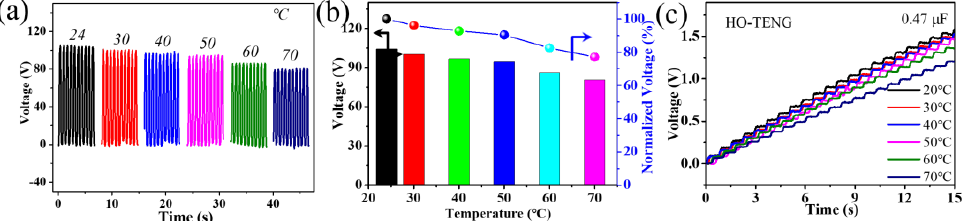
Figure 8. Electrical output of flexible HO-TENG at different operating temperature. ( a ) V oc , ( b ) normalized voltage, ( c ) charging performance of flexible HO-TENG to a commercial capacitor of 0.47 µ F. Table 1. Normalized voltage/current ( χ ) of flexible HO-TENG in this study and those of previously reported similar studies. Ref.